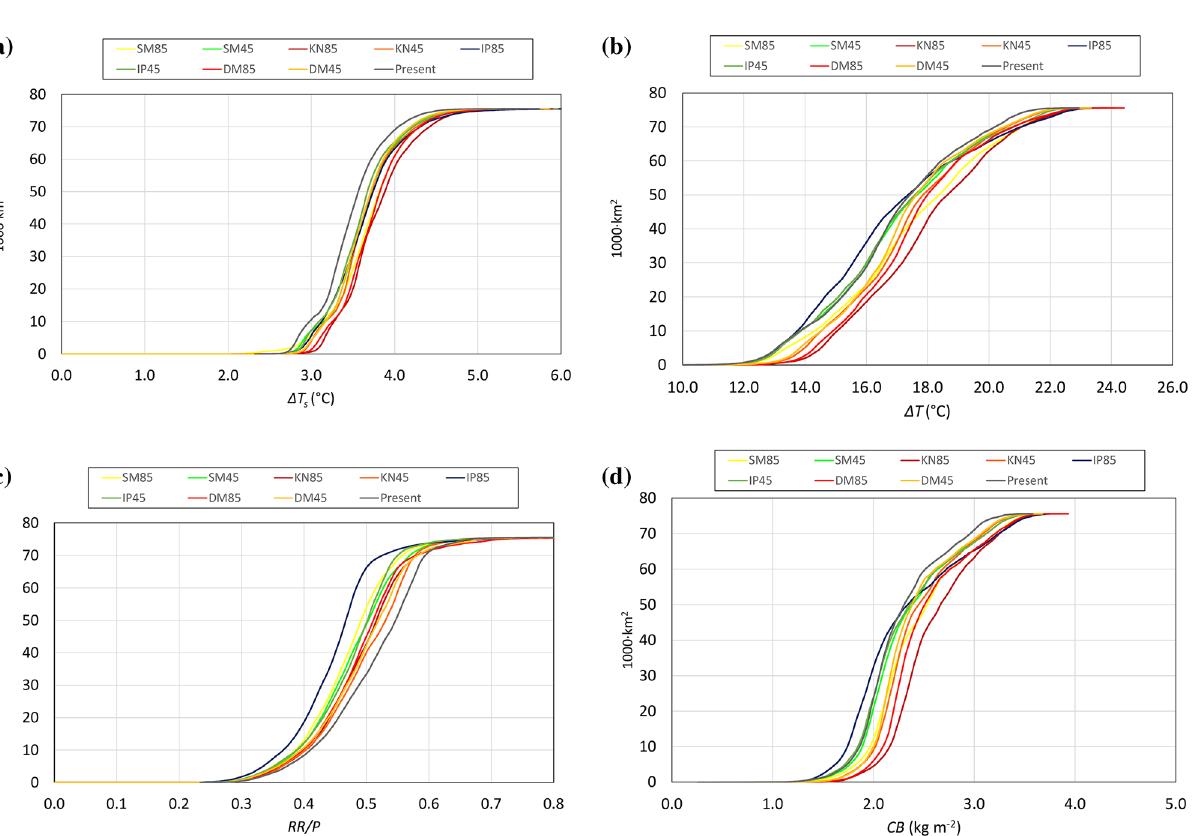
Figure 2. Cumulative curves of urban surfaces versus the indicator ΔTs (a), Δ T (b), RR / P (c) and CB (d). The black line represents present conditions, while lines in color stand each for one climatic scenario. The y-axis is the cumulative surface area of the present European urban